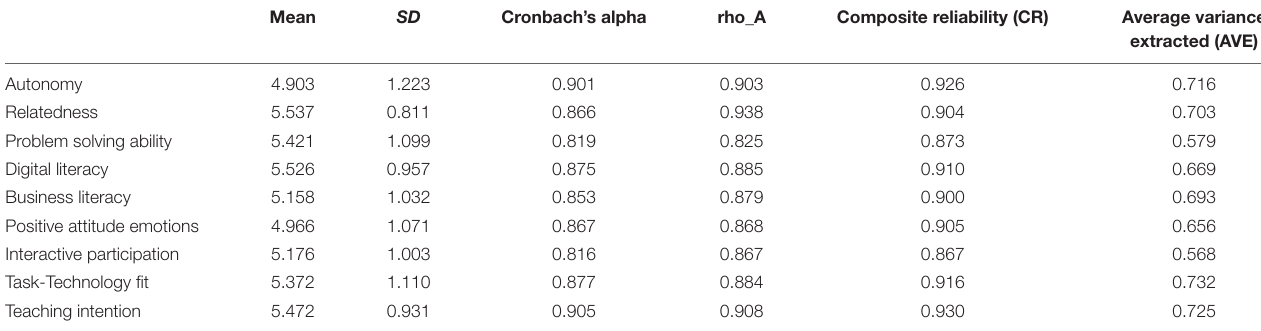
TABLE 3 | Validity and reliability of research